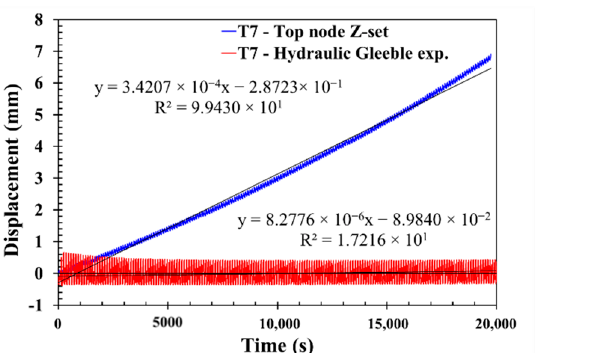
Figure 9. Experimental stroke of hydraulic cylinder for the movable jaw compared to the dis- placement of outside node at the upper end of the specimen (intersection of Top and Ext edges) to condition ( a ) T7 and ( b ) T7S calculated by the LM&C EV EP law.